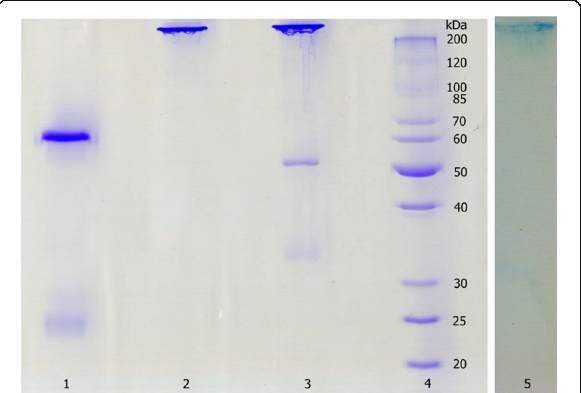
Fig 2 IgY samples from egg yolk analyzed by 12% SDS-PAGE and identified by Western blot. Lane 1 and lane 2: 10 μ g of IgY after affinity chromatography (reducing and non-reducing conditions, respectively). Lane 3: 15 μ g of IgY ’ s crude extract. Lane 4: molecular weight marker. Lane 5: identification of IgY with HRP-rabbit anti-chicken IgY by Western